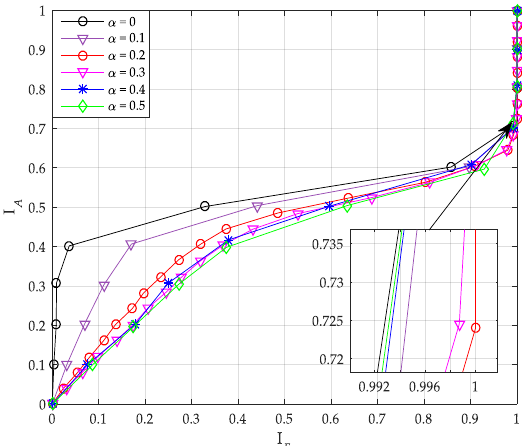
Figure 10. Transfer characteristics of systematic polar code with successive cancellation list (SCL) decoder.